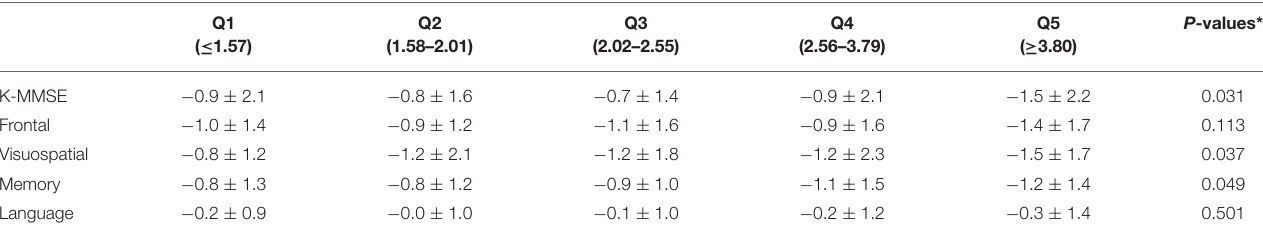
TABLE 5 | Comparison of Z scores of cognitive tests according to the quintiles of